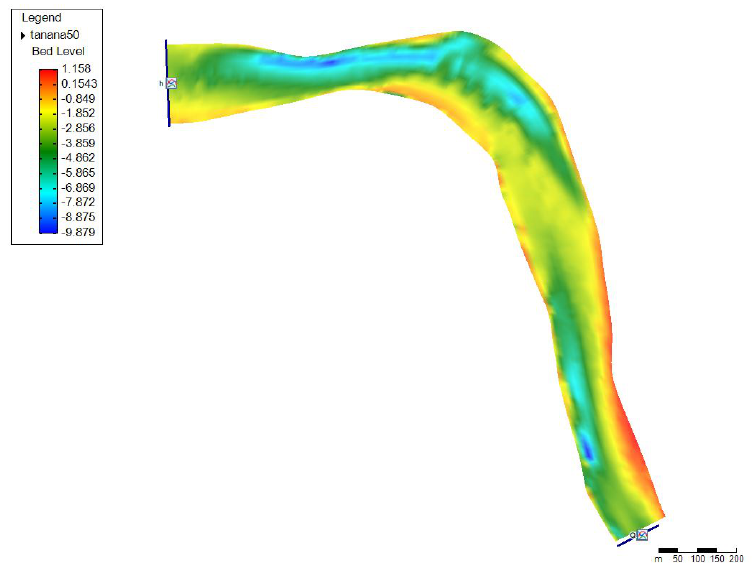
Figure 3. Depth of the river bed from the surface in meters generated from the Delft3D model based off input measured bathymetry data. The river flow direction is from the bottom right of the figure to the top left. The inlet was set to a constant discharge of 1789 m 3 /s and the outlet was set to a constant water level of 2.7 m.